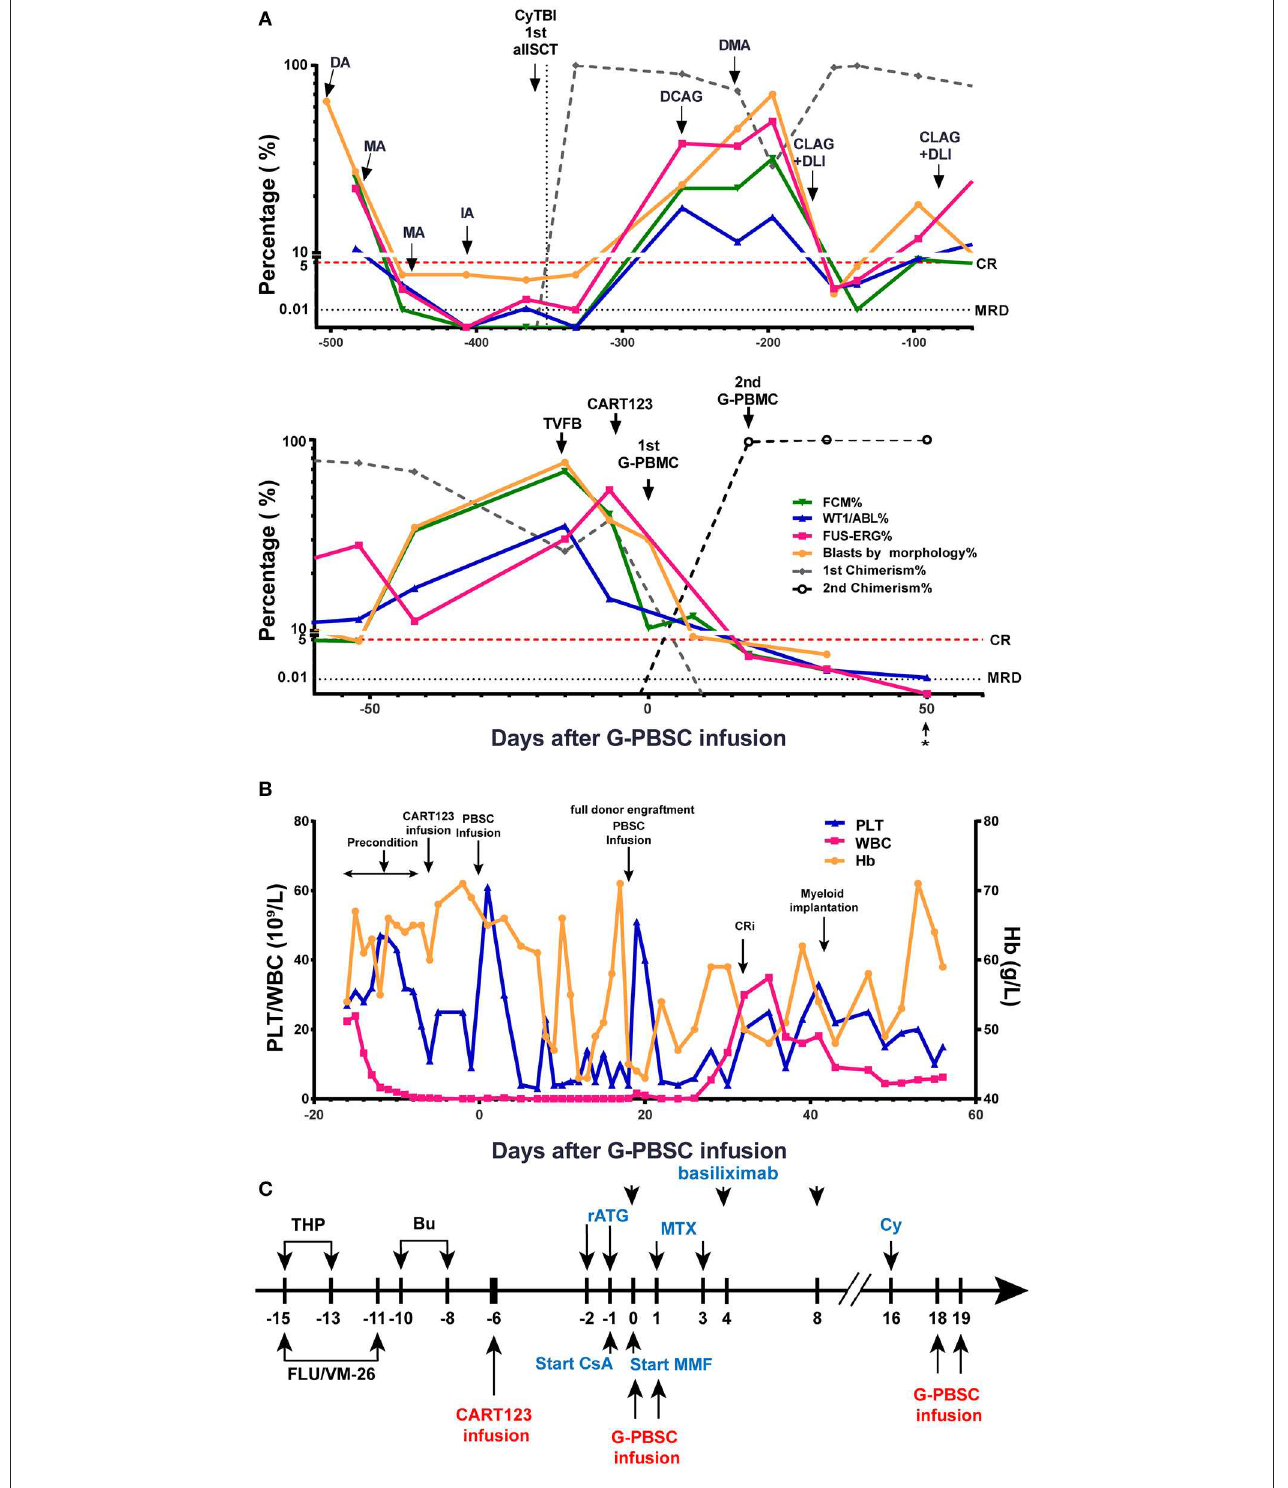
FIGURE 2 | Evaluation of clinical response and hemogram changes during treatment. (A) Changes in tumor burden and donor chimerism during treatment in BM. * data from day 56 were obtained from PB samples because the BM samples were unobtainable. (B) Hemogram changes during treatment. (C) Process of donor-derived CART123 infusion and haplo-HSCT. The patient received a RIC regimen of TVFB and CART123 infusion. Given that the patient possibly developed an